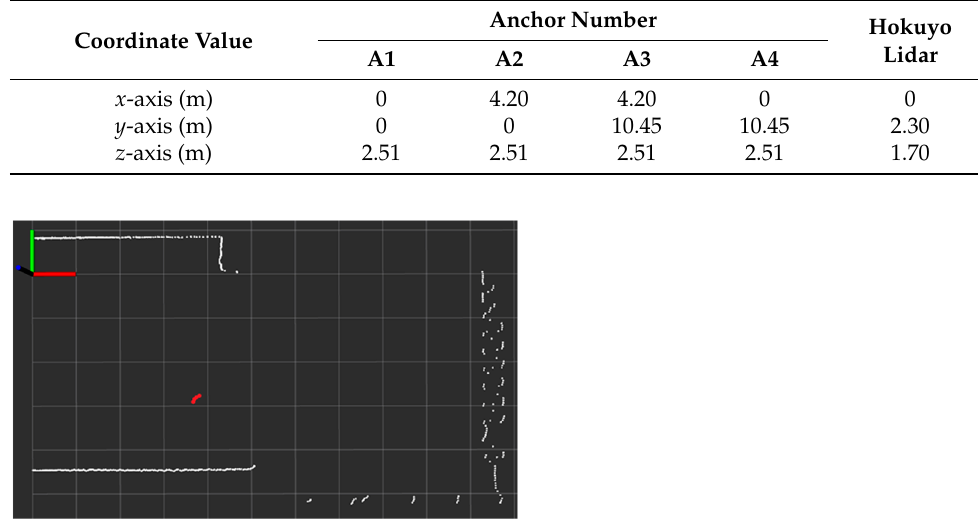
Figure 9. Experiment environment. ( a ) Top view of experimental setup; ( b ) site photos with two views of hardware deployment. Table 2. Experimental setup configuration. Table 2. Experimental setup configuration.